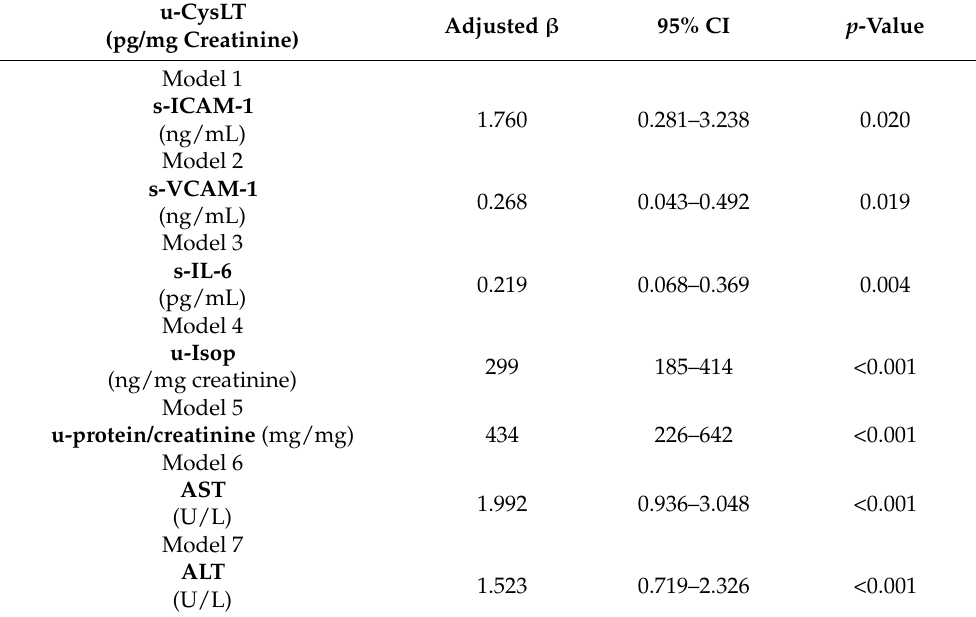
Table 5. Repeated-measure multivariate models for u-CysLT in SS patients throughout hospitaliza- tion. Adjusted β , 95% confidence intervals (95% CI), and p -value estimated by repeated-measure multivariate models with u-CysLT as the dependent variable and adjusted for age, gender, and eGFR. u-CysLT Adjusted β 95% CI p -Value (pg/mg Creatinine) Model 1